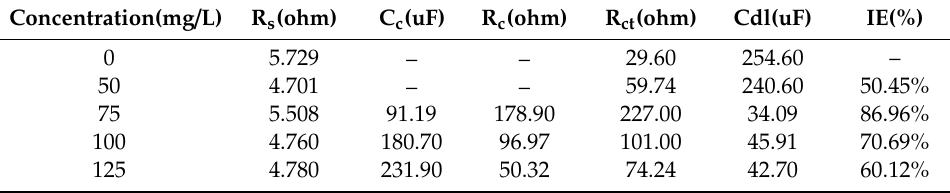
Table 3. Fitted EIS results of iron corroding in 1 mol / L HCl solutions at di ff erent lignin-DMC.